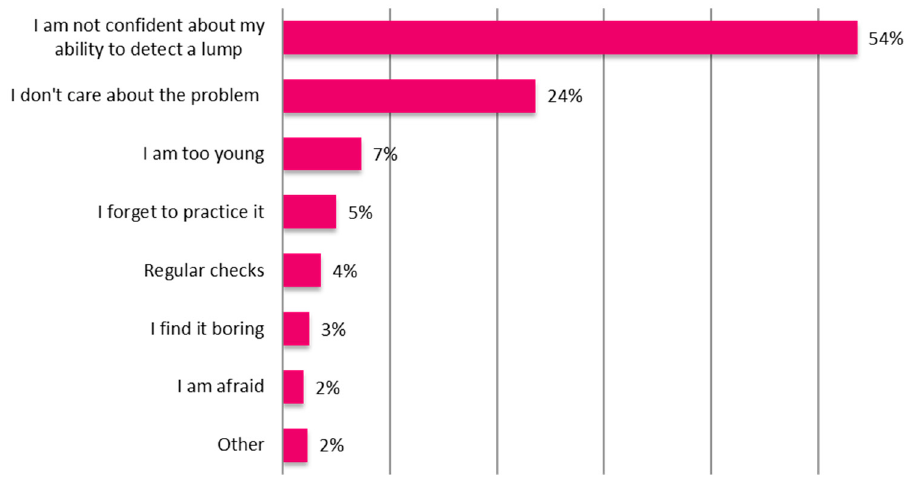
Figure 2. Questionnaire results—percentage of responses to the question “Why don’t you practice breast self-examination (BSE)?”